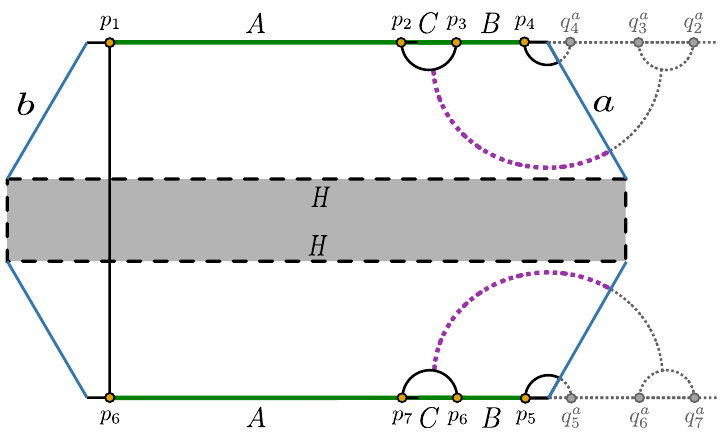
Figure 35 . The endpoints of the intervals A and B and the image points in the two BCFT 2 copies are identified similarly as in figures 20 and